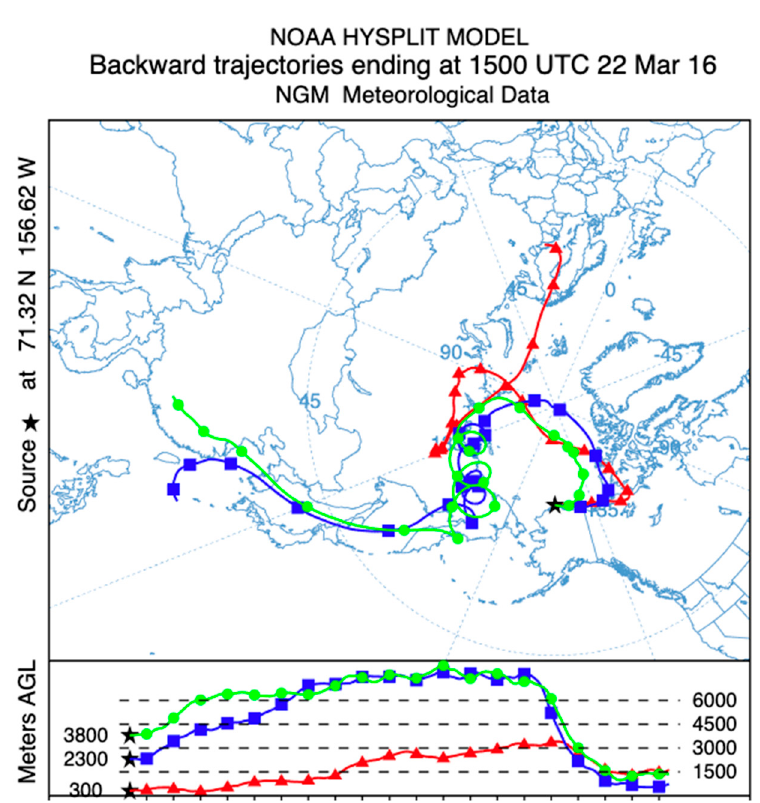
Figure 4. HYSPLIT 20 days of backward-trajectories starting at the three altitudes at the NSA site on 22 March 2016, 15:00 UTC.